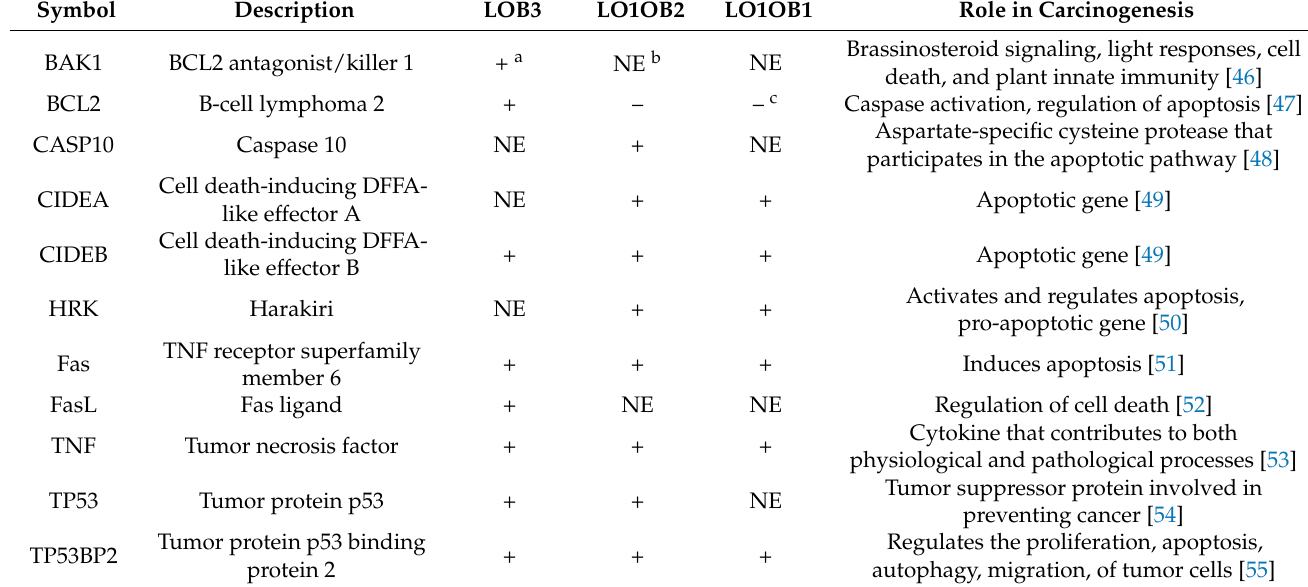
Table 4. Curated list of genes up- or down-regulated in Calu-3 exposed to